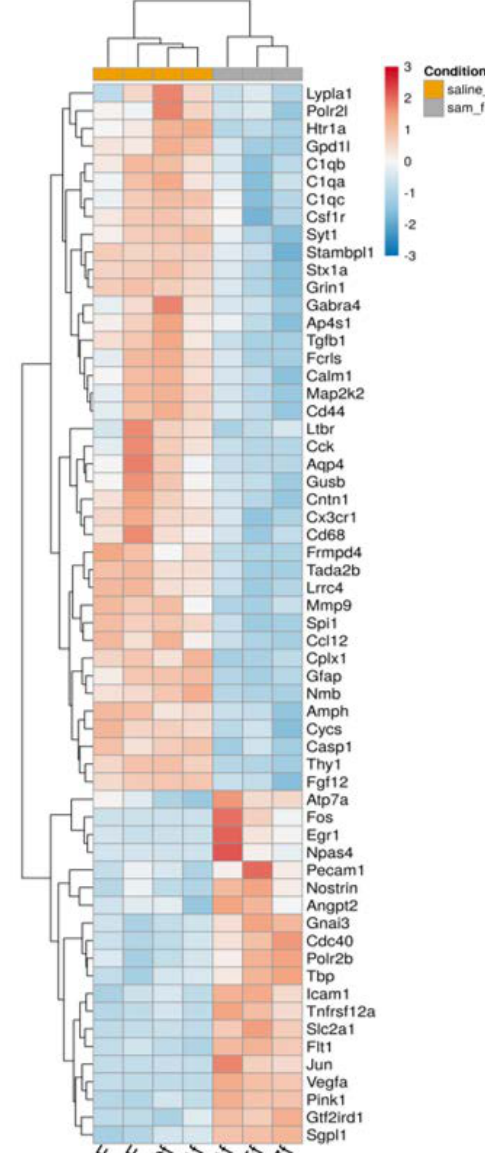
Figure 4. Heat maps in the di ff erent groups: Int. J. Mol. Sci. 2020 , 21 , x FOR PEER REVIEW